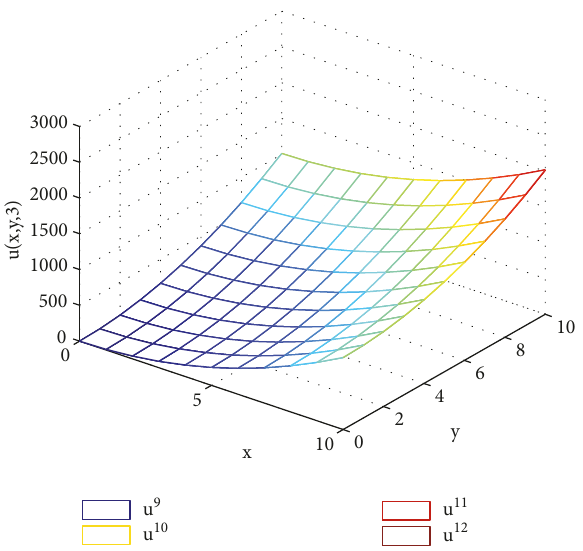
Figure 6: The approximate solutions 𝑢 9 , 𝑢 10 , 𝑢 11 , and 𝑢 12 of (49) at 𝑡 = 3 with 𝛼 = 1 .